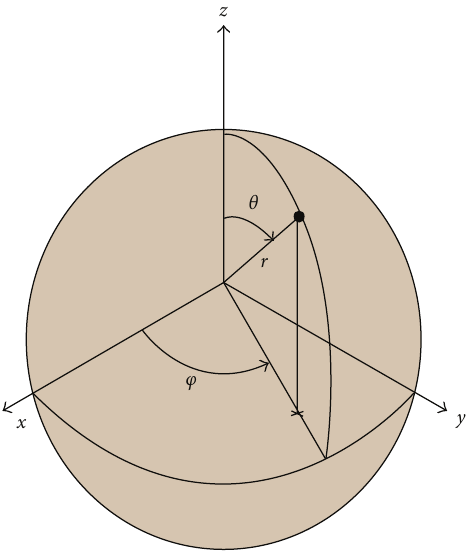
Figure 1: Reference adopted in the field